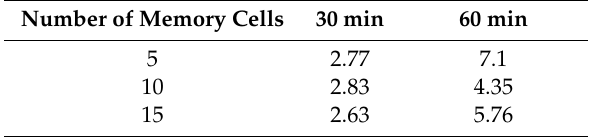
Table 2. RMSE values in mg / dL. A total of 8 days of data for training with 2 di ff erent days for